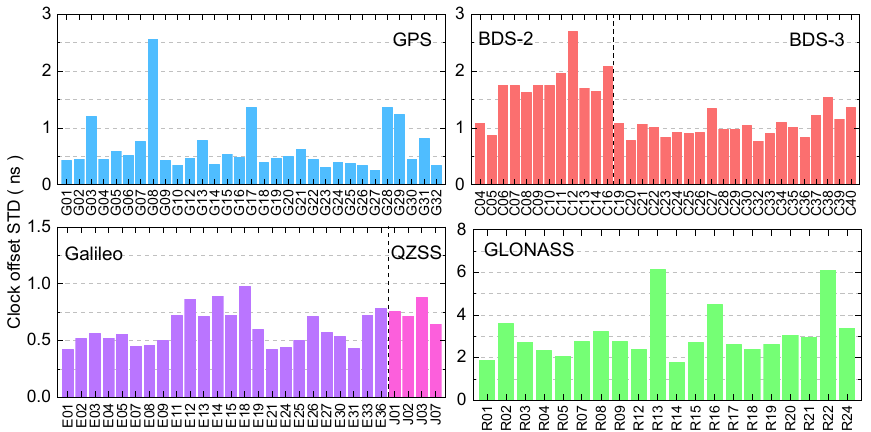
Figure 5. Clock offset accuracy of GPS/BDS-2/BDS-3/Galileo/GLONASS/QZSS satellites from broadcast ephemeris.